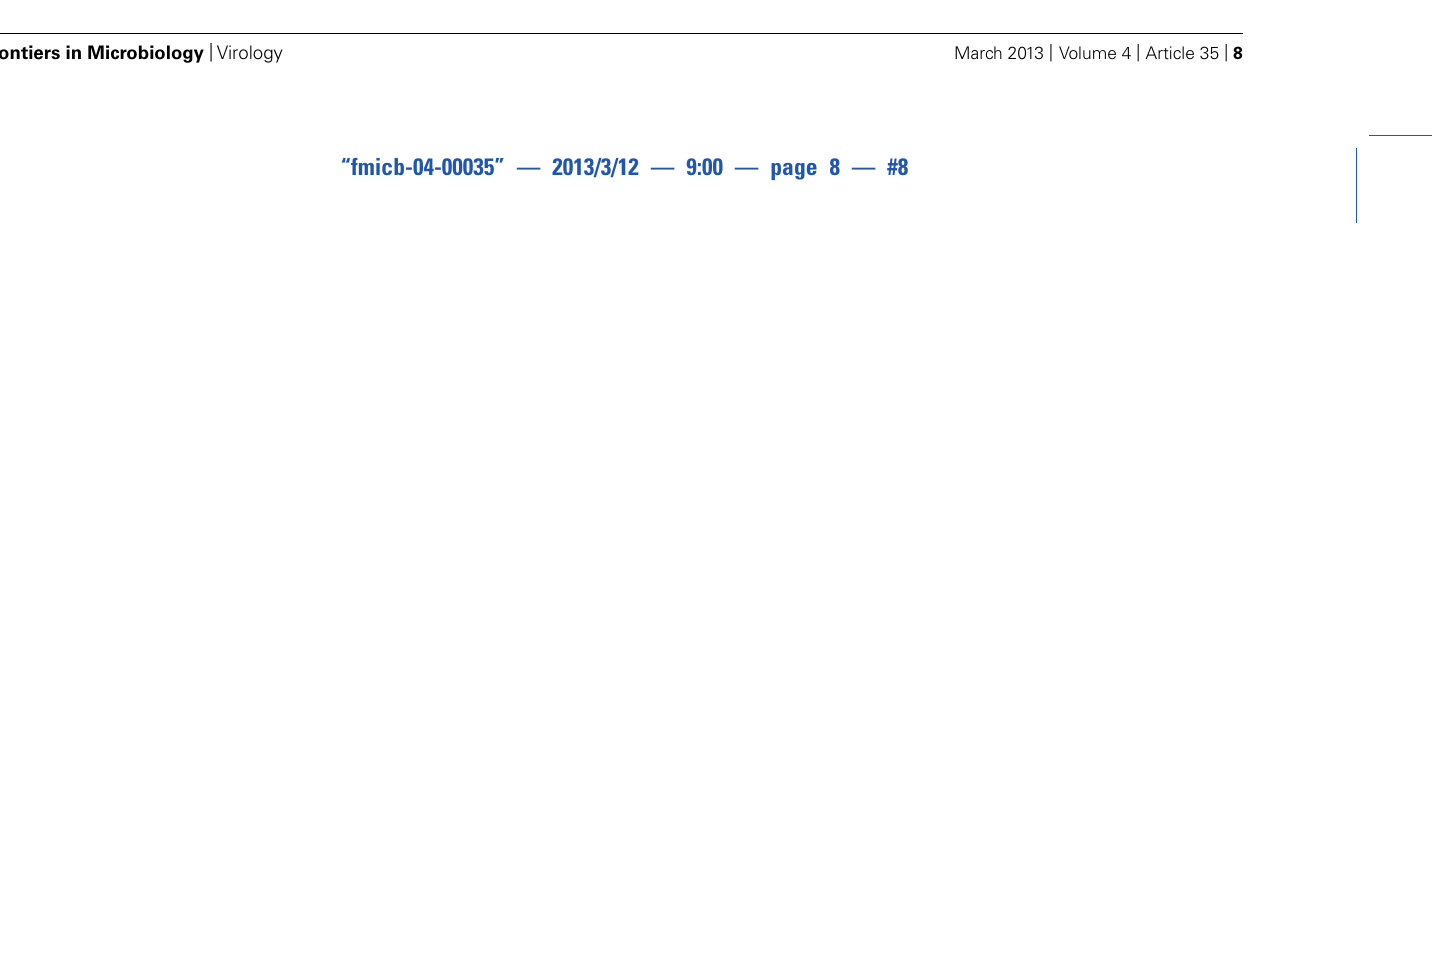
FIGURE 5 | Cell type-specific outcomes of KSHV interactions with CD36 and CD147 signaling pathways. (A) In melanoma-derived cells (Mel1700), KSHV upregulates both CD36 (and its ligand,TSP-1) and CD147 (as shown in Figure 4 ). Binding of the Pf EMP-1 CIDR1 α -derived peptide, MC179, to virus-upregulated CD36 prevents Akt phosphorylation while inducing RTA-dependent KSHV reactivation via the MAPK/p38 pathway. Remarkably, structural mimics of MC179, such as the helical heptad repeat (HR) regions derived from KSHV glycoprotein B (gB), can, like MC179, also induce virus reactivation in a CD36-dependent manner (as shown in Figure 3 ). (B) In lymphatic (LEC) and other endothelial cells such as mixed tolemerase- immortalized dermal microvascular and brain endothelial cells (tDMB),